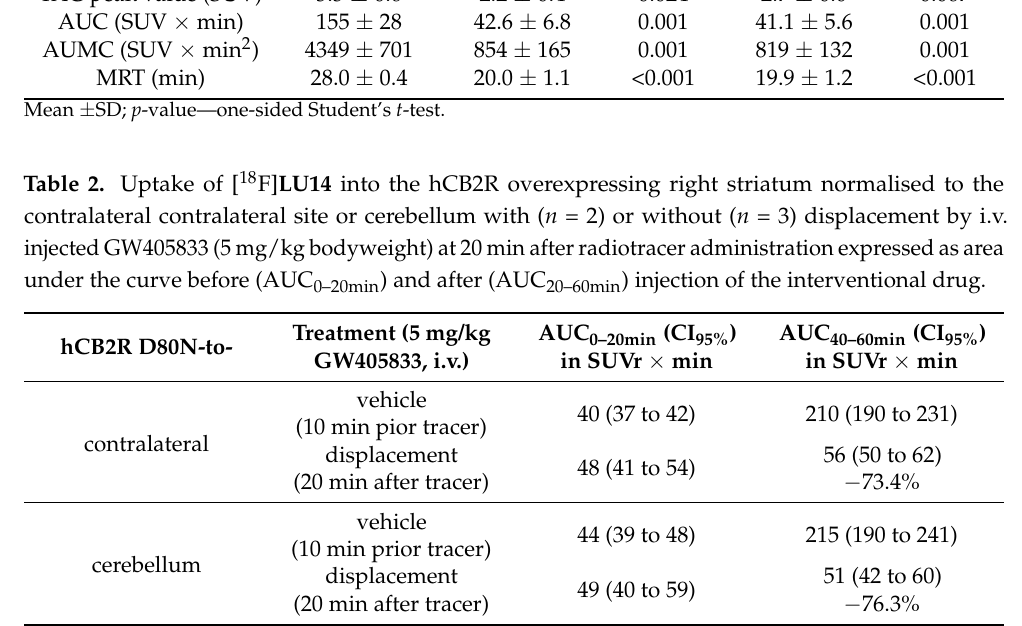
Table 1. Non-compartmental analysis of TACs in the region of local overexpression of the hCB2R(D80N) in the right striatum of rats, the contralateral region and the cerebellum after i.v. injection of [ 18 F] LU14 ( n = 3). TAC Parameter hCB2R(D80N) Contralateral p -Value Cerebellum p -Value time to peak (min)